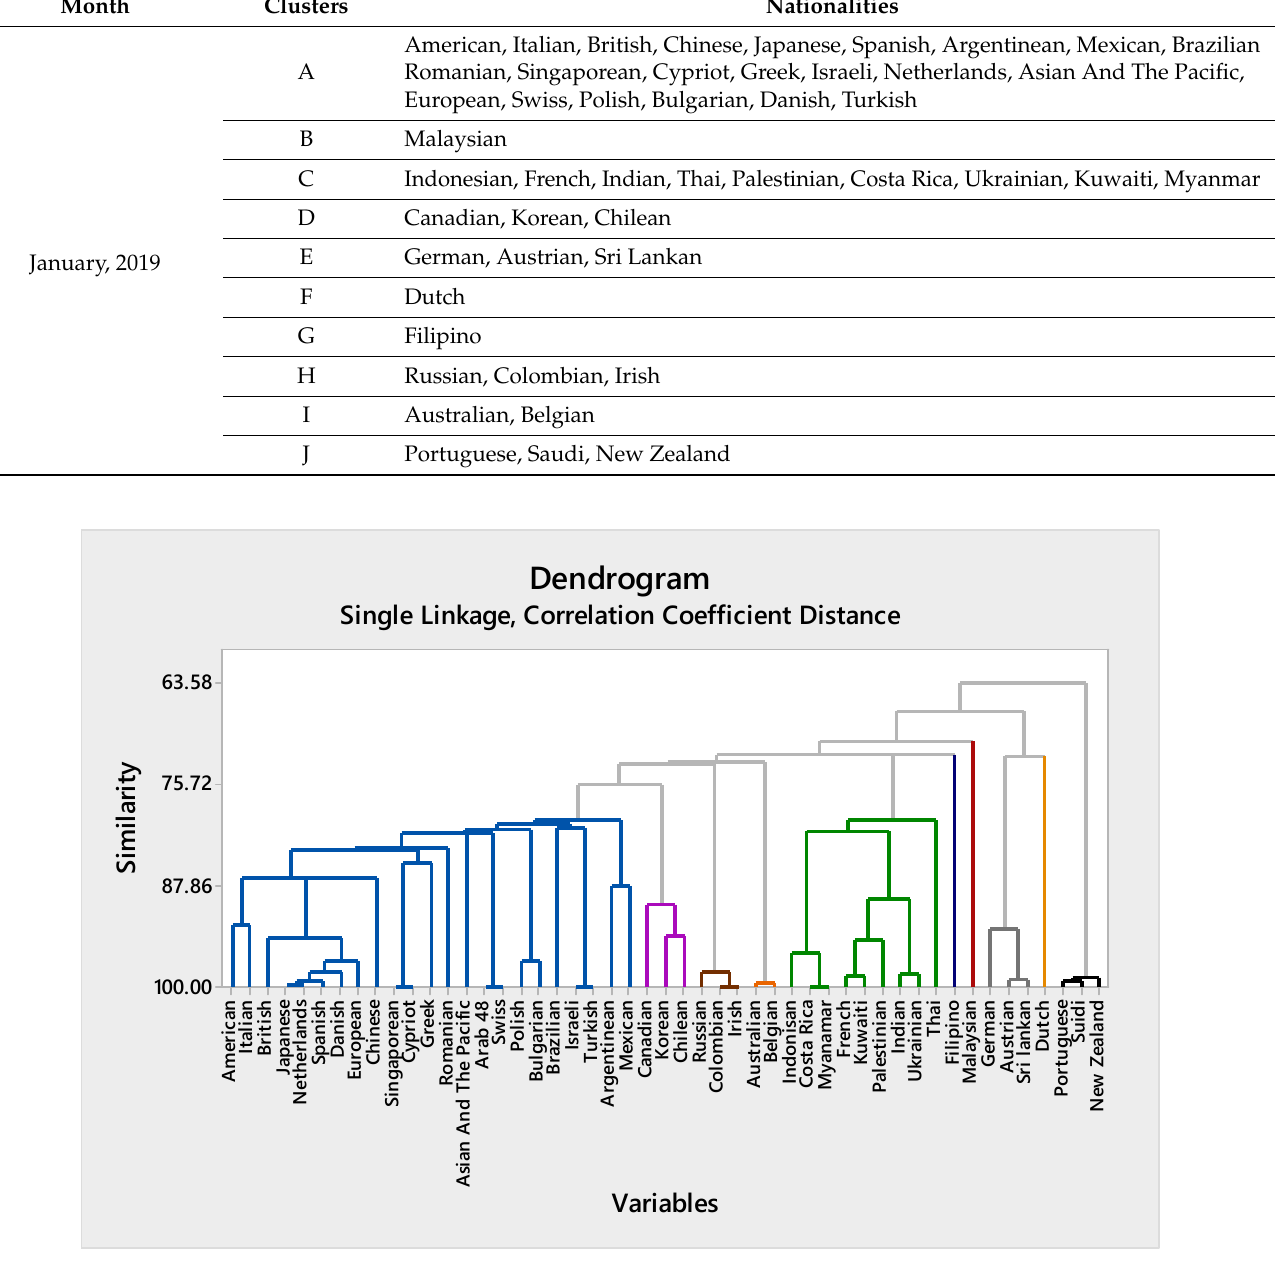
Figure 4. Dendrogram for January, 2019 using single linkage clustering algorithm when N = 10 (scenario I) .